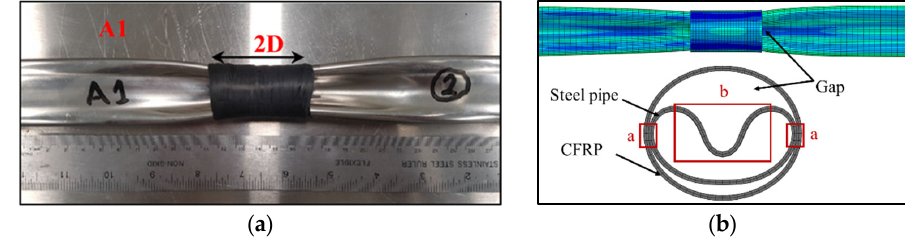
Figure 3. U ‐ shape buckling propagation through arrestor ( a ) Experiment result, ( b ) Simulation result [44].